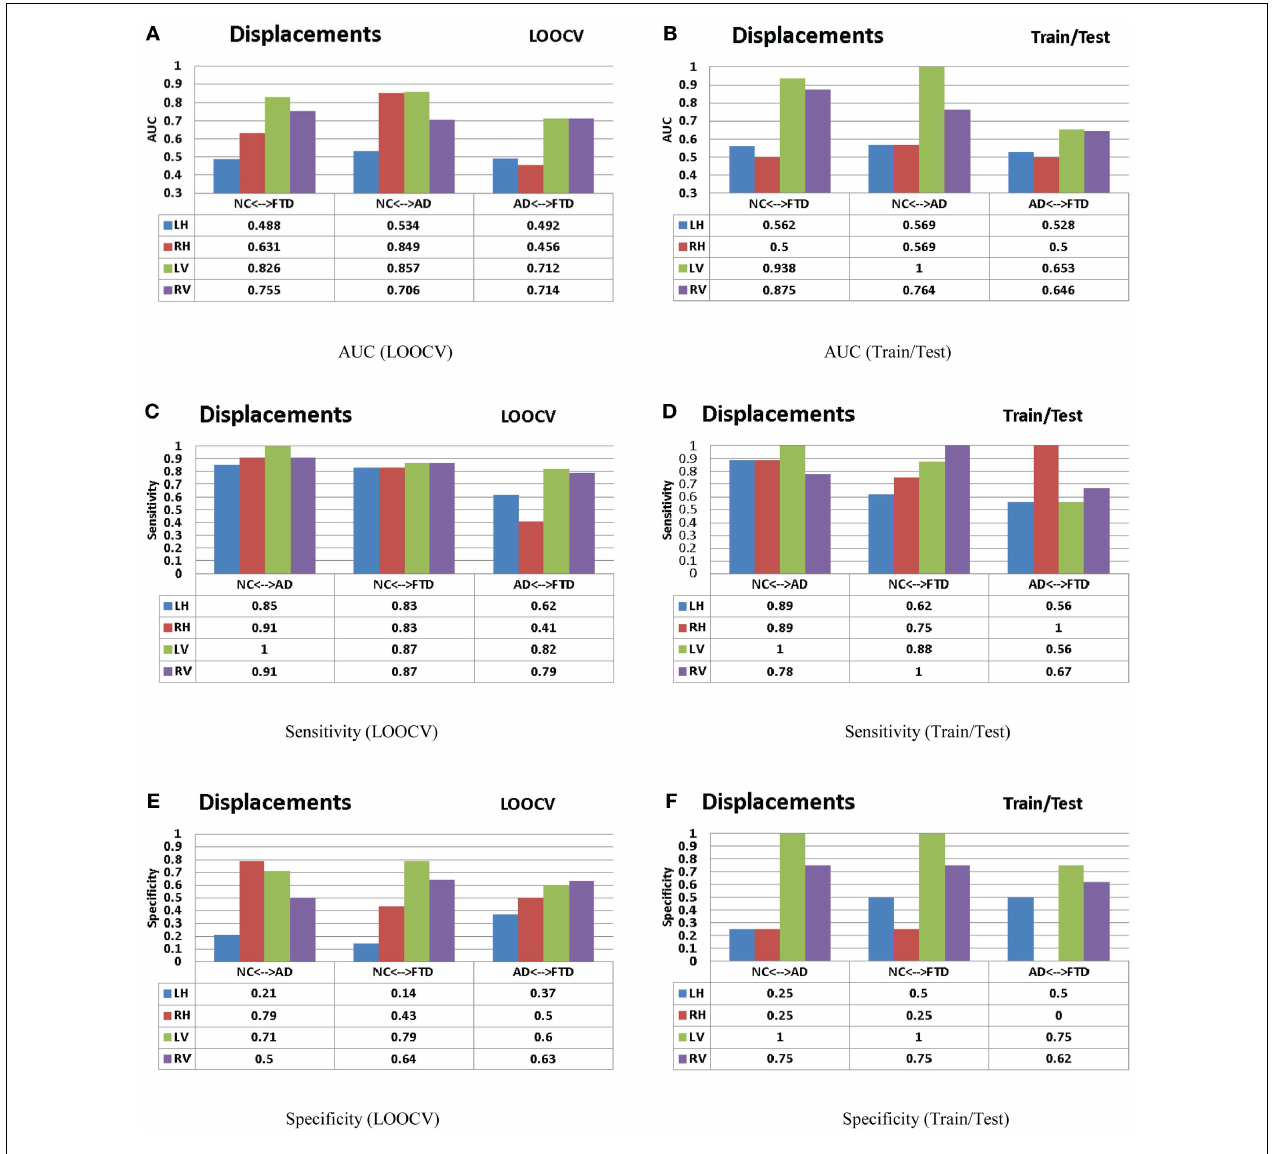
FIGURE 12 |TheAUC, sensitivity, and specificity metrics obtained from the LOOCV and train/test experiments as described in the Section “Leave-One-Out Cross-Validation” (left column) and Section “Train/Test Scenario” (right column) respectively are shown here for the